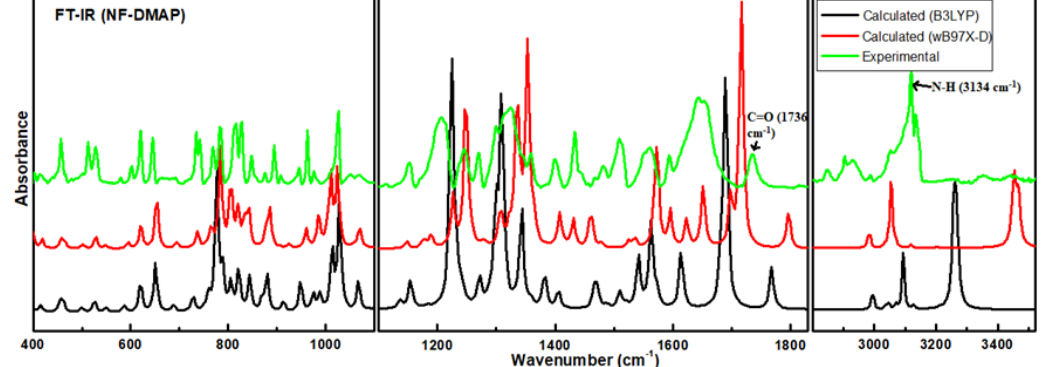
Figure 3. Experimental and theoretical IR spectra for NF-DMAP in the range 3600–400 cm − 1 .